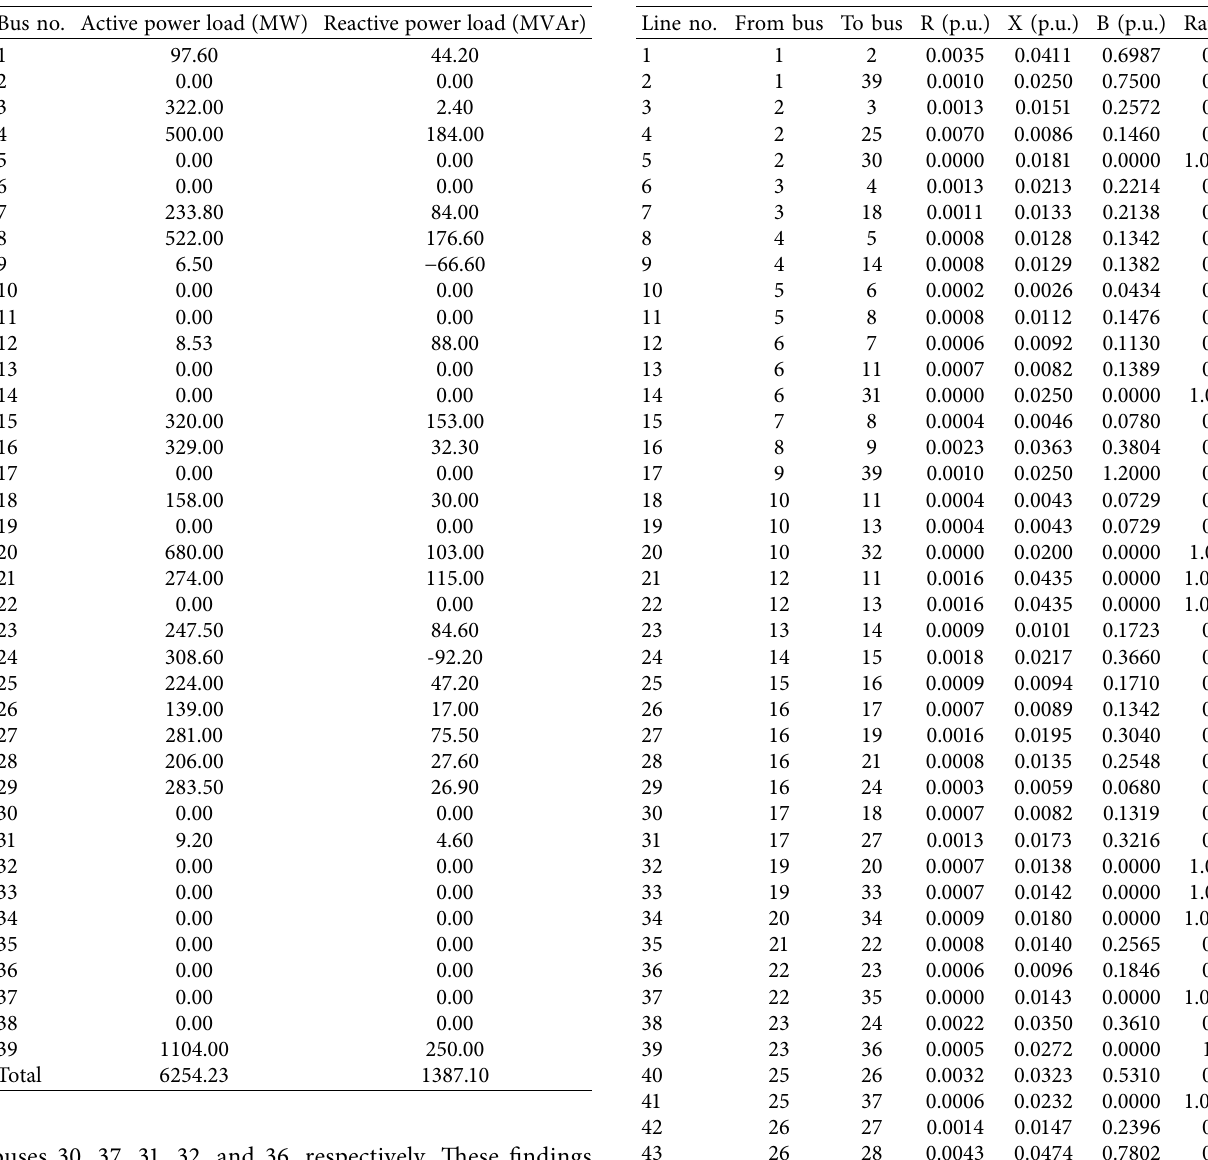
Table 15: Transmission line data [55]. Table 14: Bus data